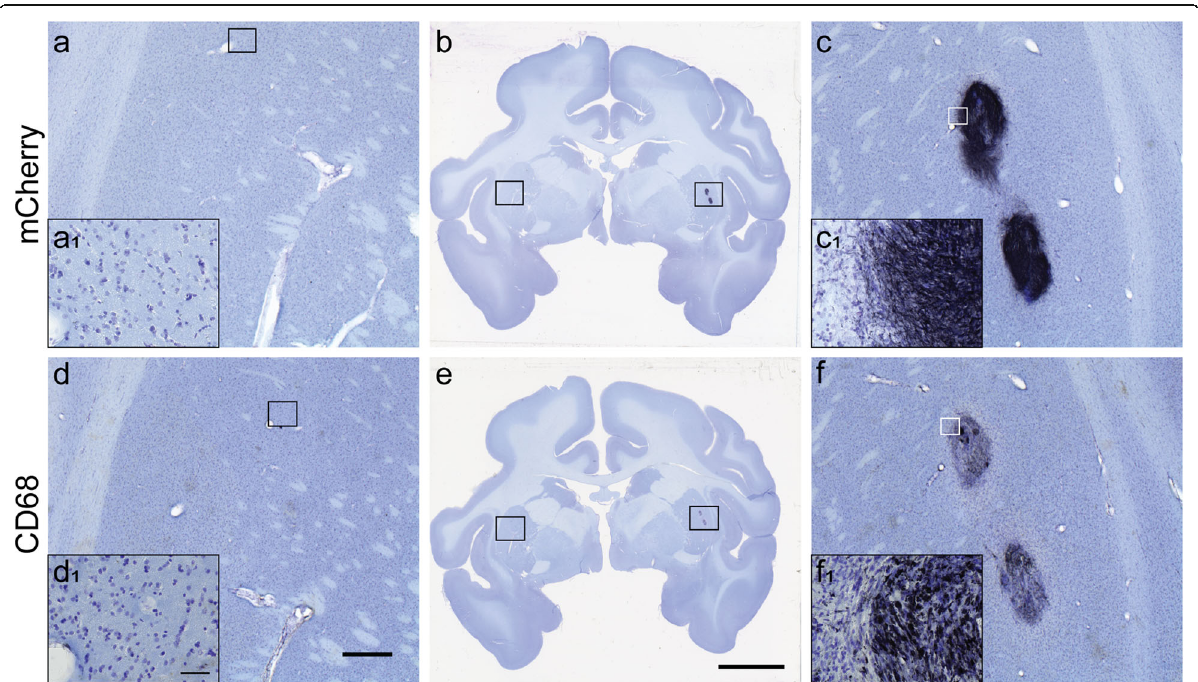
Fig. 5 mCherry ( a – c ) and CD68 immunostained ( d – f ) brain tissue sections counterstained with Nissl from the hemiparkinsonian monkey R4 with unilateral allogeneic grafts in the postcommisural putamen. Images a , c and d , f correspond to higher magnification of the squares in coronal brain sections b and e respectively. Insets a 1 , c 1 , d 1 , and f 1 are higher magnification of the square in panels a , c , d , and f respectively. Scale bars: d , 1 mm; e , 10 mm; d